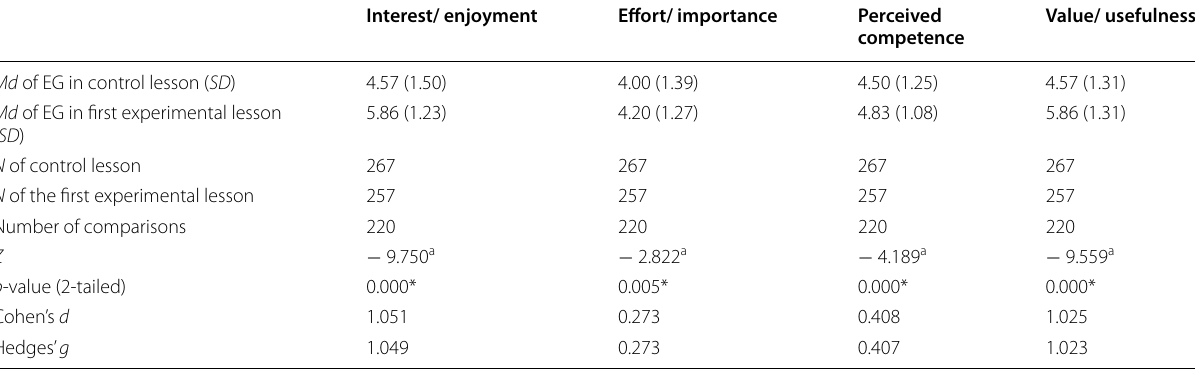
Table 3 Change in the students’ intrinsic motivation in the EG between the control lesson (Post-Questionnaire 1) and the first experimental lesson (Post-Questionnaire 2_1) (Wilcoxon signed-rank